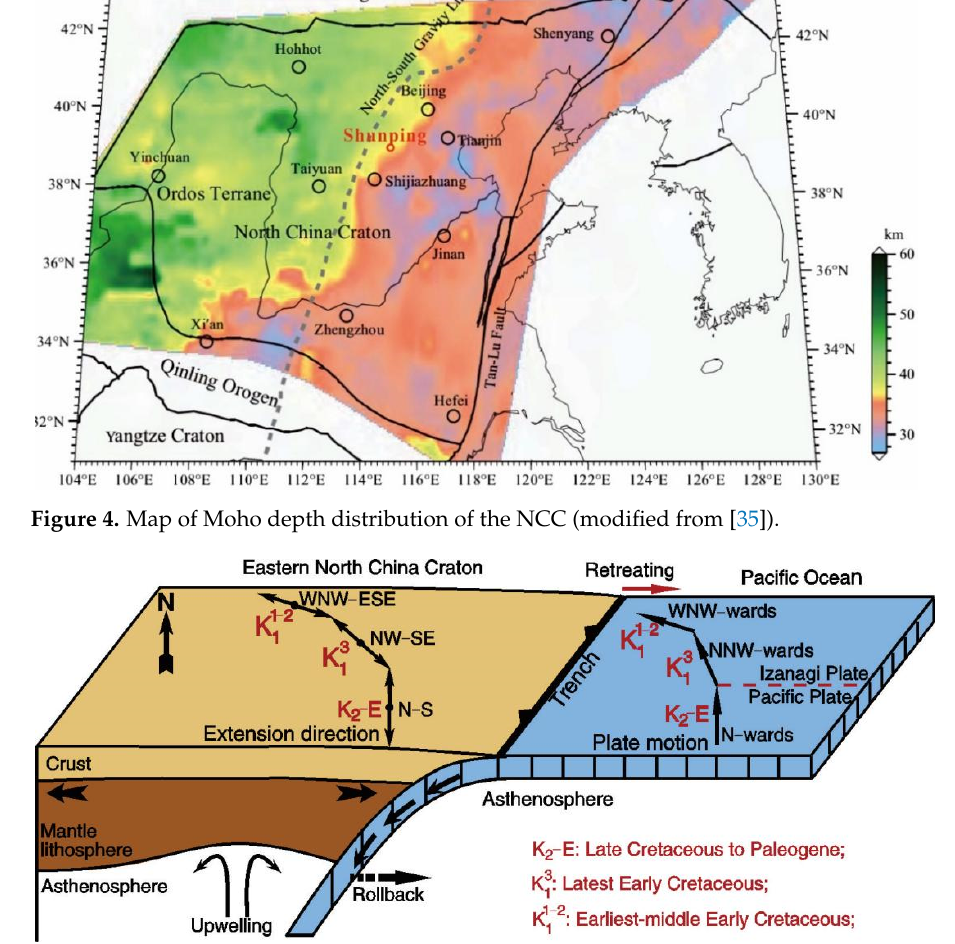
Figure 5. Kinematic comparison between the principal extension direction in the eastern NCC and plate motion direction in the Pacific Ocean [41].